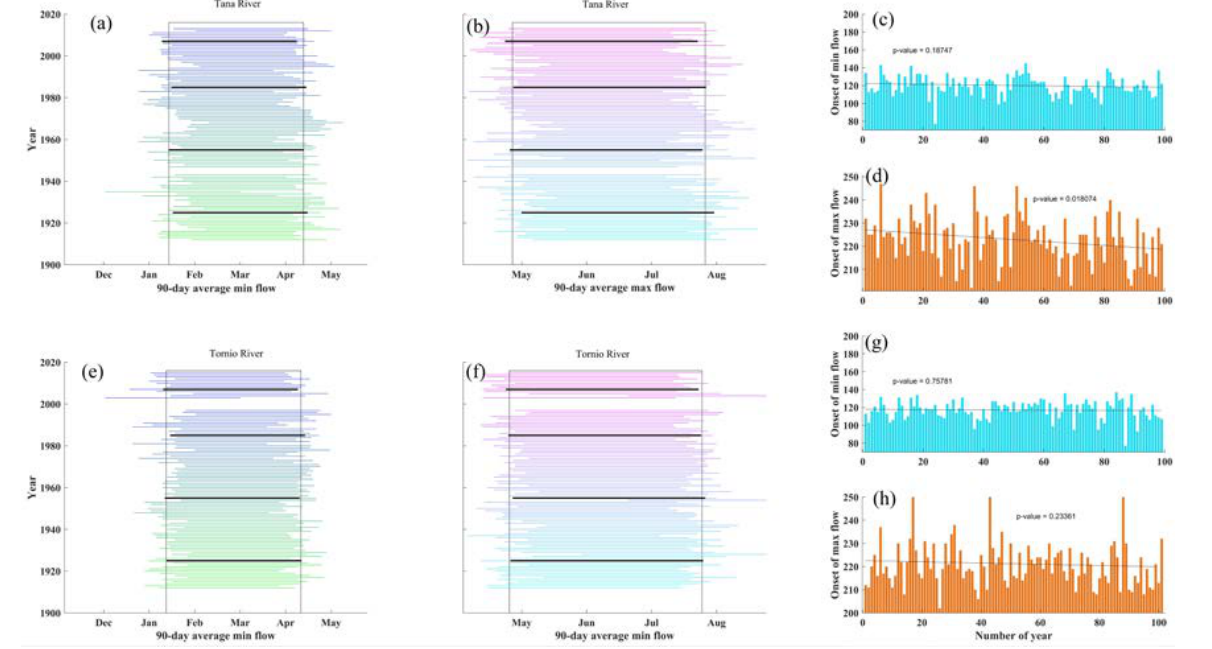
Figure 8. 90-day periods of low and high flow, ( a ) low flow in the Tana River, ( b ) high flow in the Tana River, ( c ) trend of low flow starting date in the Tana River, ( d ) trend of high flow starting date in the Tana River, ( e ) low flow in the Tornio River, ( f ) high flow starting date in the Tornio River, ( g ) trend of low flow starting date in the Tornio River, ( h ) trend of high flow starting date in the Tornio River.